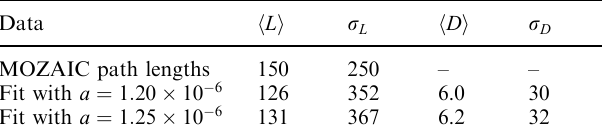
Table 1. Mean values h L i and standard deviations r L of path length distribution N (cid:133) L (cid:134) for flights through ice-supersaturated regions according to MOZAIC data and two fits according to the mathematical model described in the text. The mean ‘‘true’’ diameters, h D i , of the assumed circular ice-supersaturated regions and the corresponding standard deviations r D are also given. All quantities are in units of kilometres